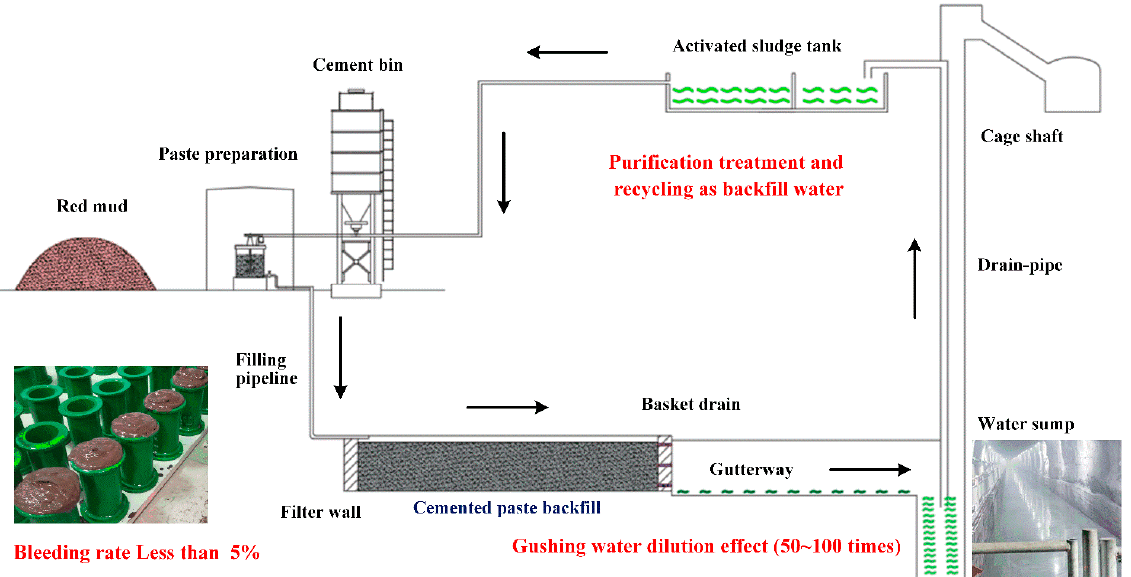
Figure 3. Groundwater recycling process of RCB.